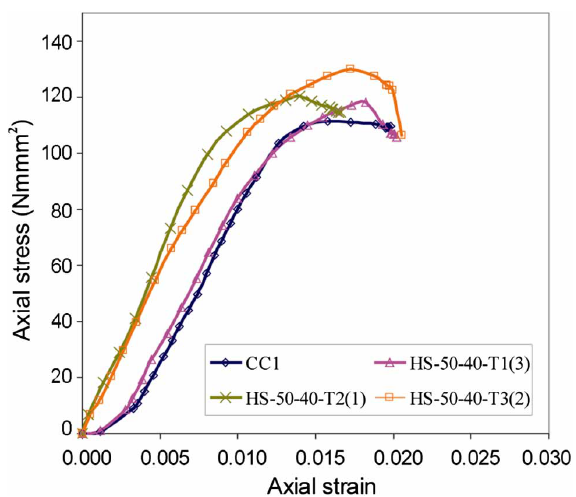
Fig. 11. Axial stress strain behaviour of columns HS-50-20 (cid:1) comparison